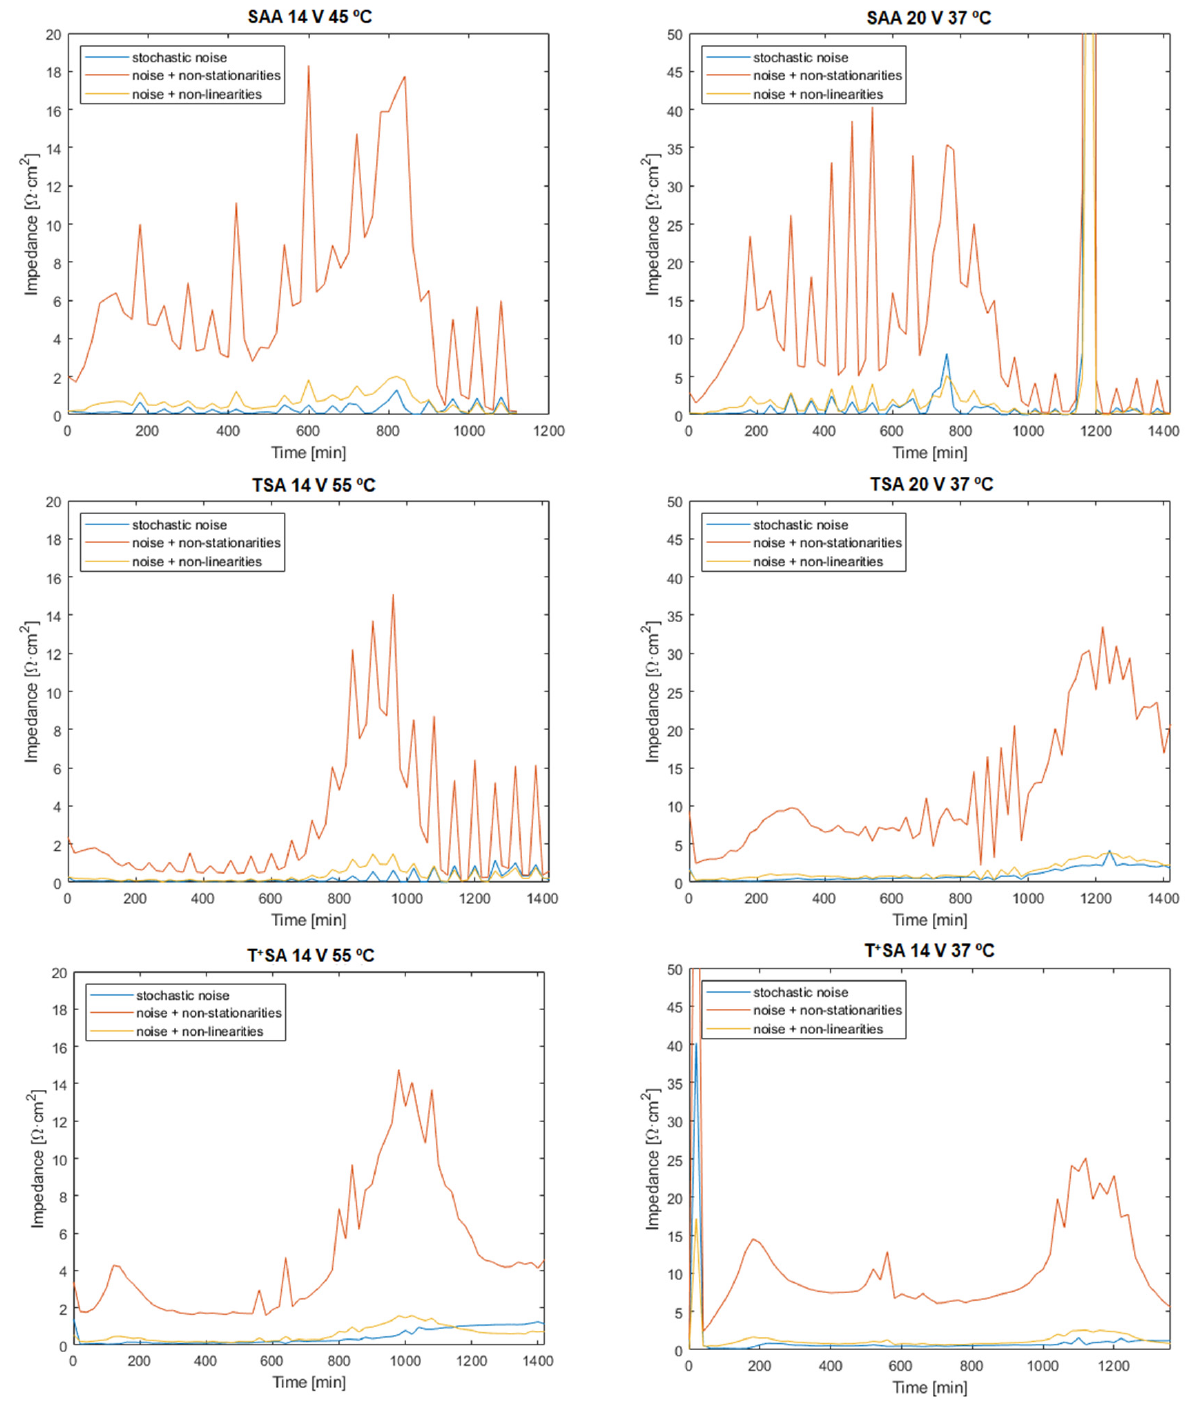
Figure 10. Noise, non-linearities, and non-stationarities measured at 100 Hz during immersion of the anodic oxide films in an acidified diluted Harrison solution by ORP-EIS.